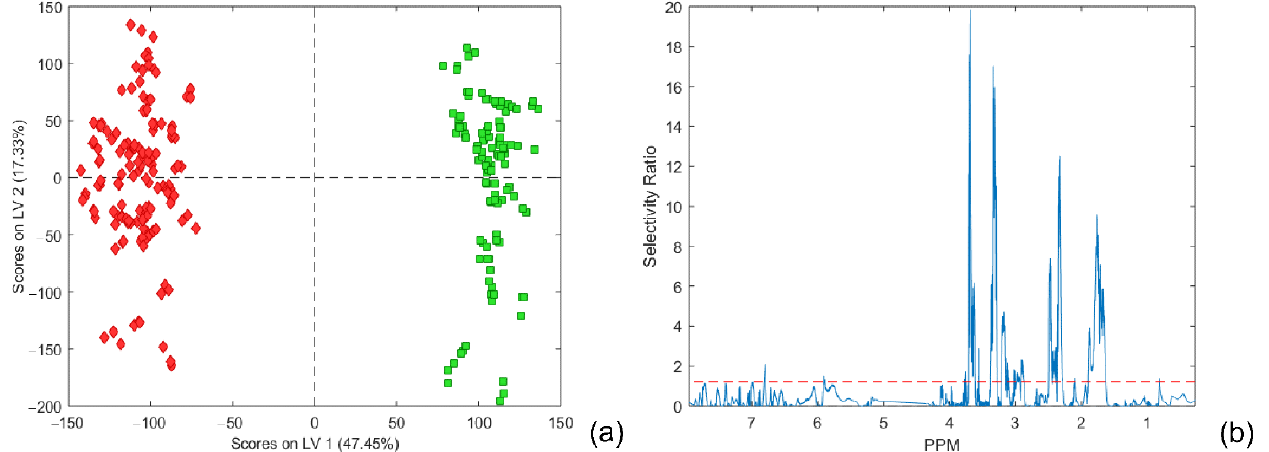
Figure 5. ( a ) Score plot of the first predictive LV 1 and the first orthogonal LV 2 components (for a 4-component model, RMSEC = 0.0845 and RMSECV = 0.1071). The schizophrenia cohort is shown in red, and the control group in green. ( b ) Selectivity ratio plot.